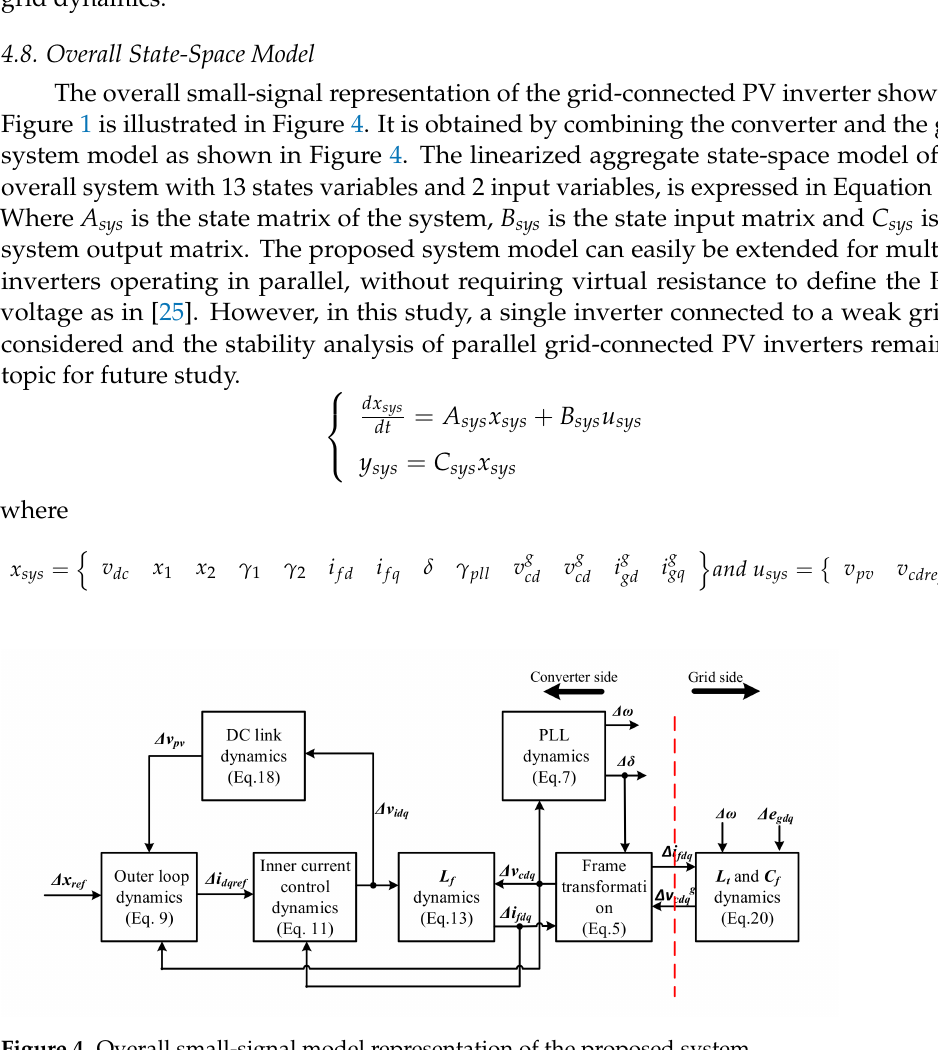
Figure 4. Overall small-signal model representation of the proposed